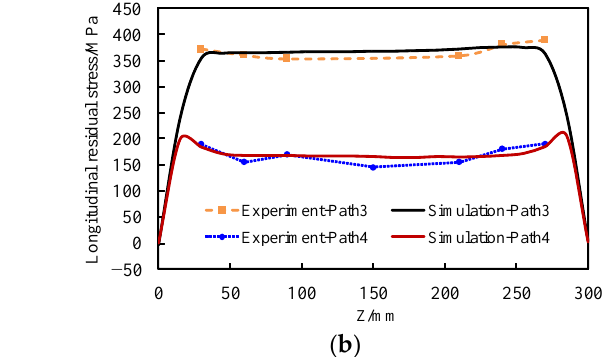
( a ) ( b ) Figure 9. Distribution of x  and z  on Paths P3 and P4: ( a ) x  ; ( b ) z  . Figure 9. Distribution of σ x and σ z on Paths P3 and P4: ( a ) σ x ; ( b ) σ z